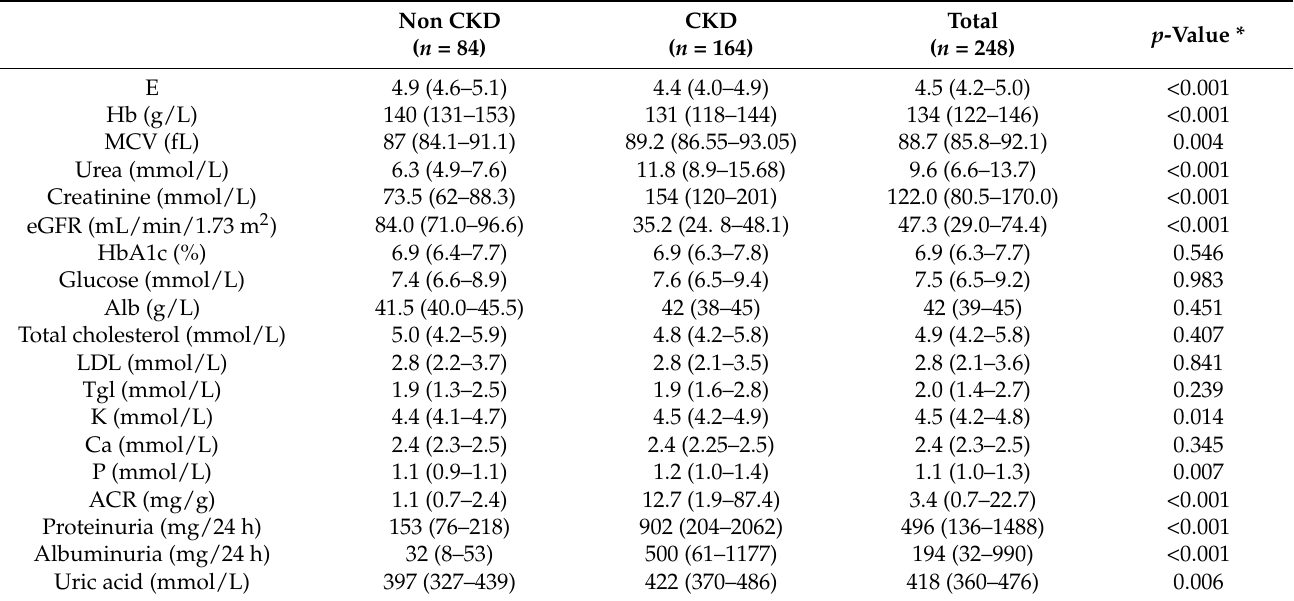
Table 2. Biochemical parameters of the study population and differences among DDHP with present CKD and without present CKD.